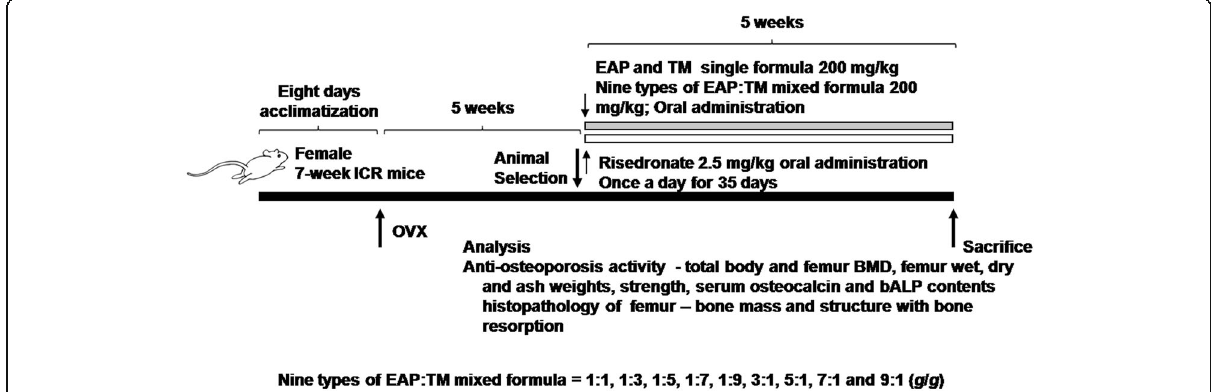
Fig. 1 Study experimental design. OVX: Bilateral ovariectomy; RES: Risedronate sodium; EAP: Exopolymers purified from A. pullulans SM2001; TM: T. morbifera leaf extracts; (EAP:TM): Mixed formula consisted of EAP and TM ( g / g